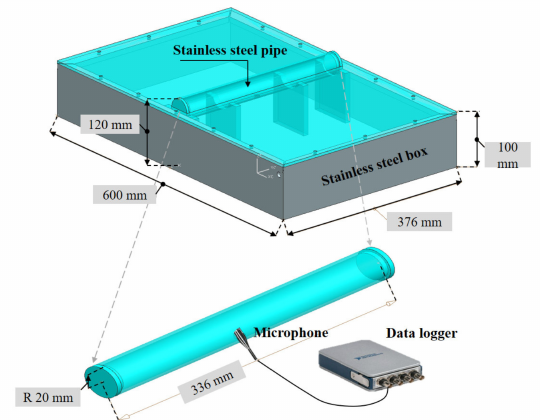
Figure 6. Pipe hydrophone main components and specifications. Adapted from